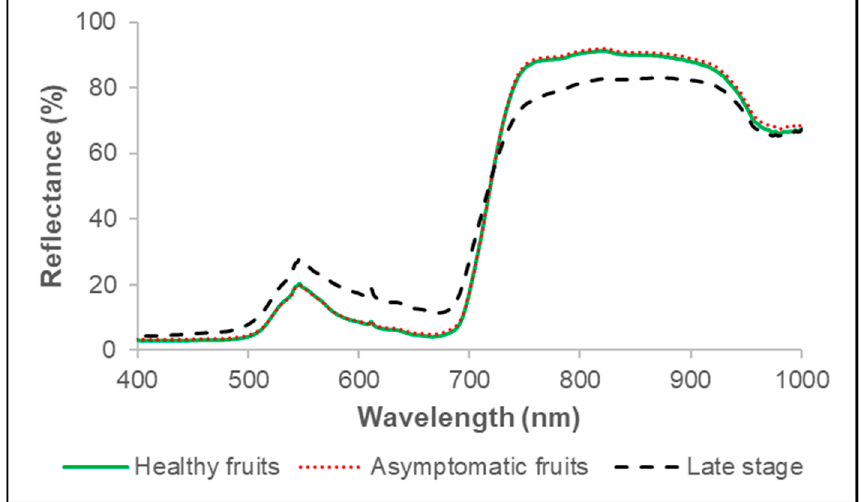
Figure 7. The spectral structure of immature (green) fruit in a healthy stage and in two disease developmental stages. The hyperspectral signature of Sugar Belle immature fruit in healthy, asymptomatic, and late canker stages are shown with different colored lines.